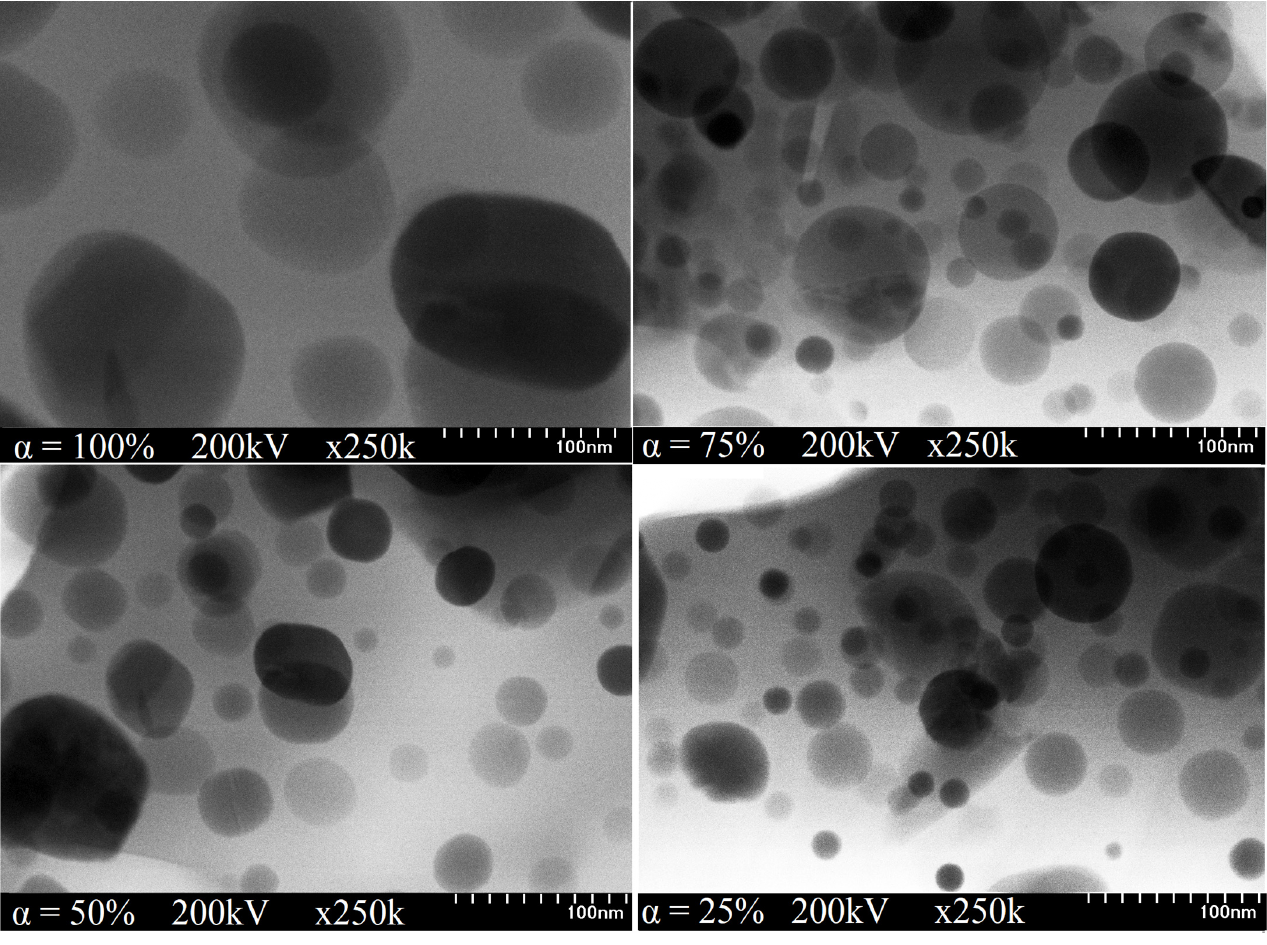
Figure 5. TEM images of (Co 0.4 Zn 0.4 Ni 0.2 Fe 2 O 4 ) α (SiO 2 ) 100 − α samples ( α = 25–100%) annealed at 1200 °C.